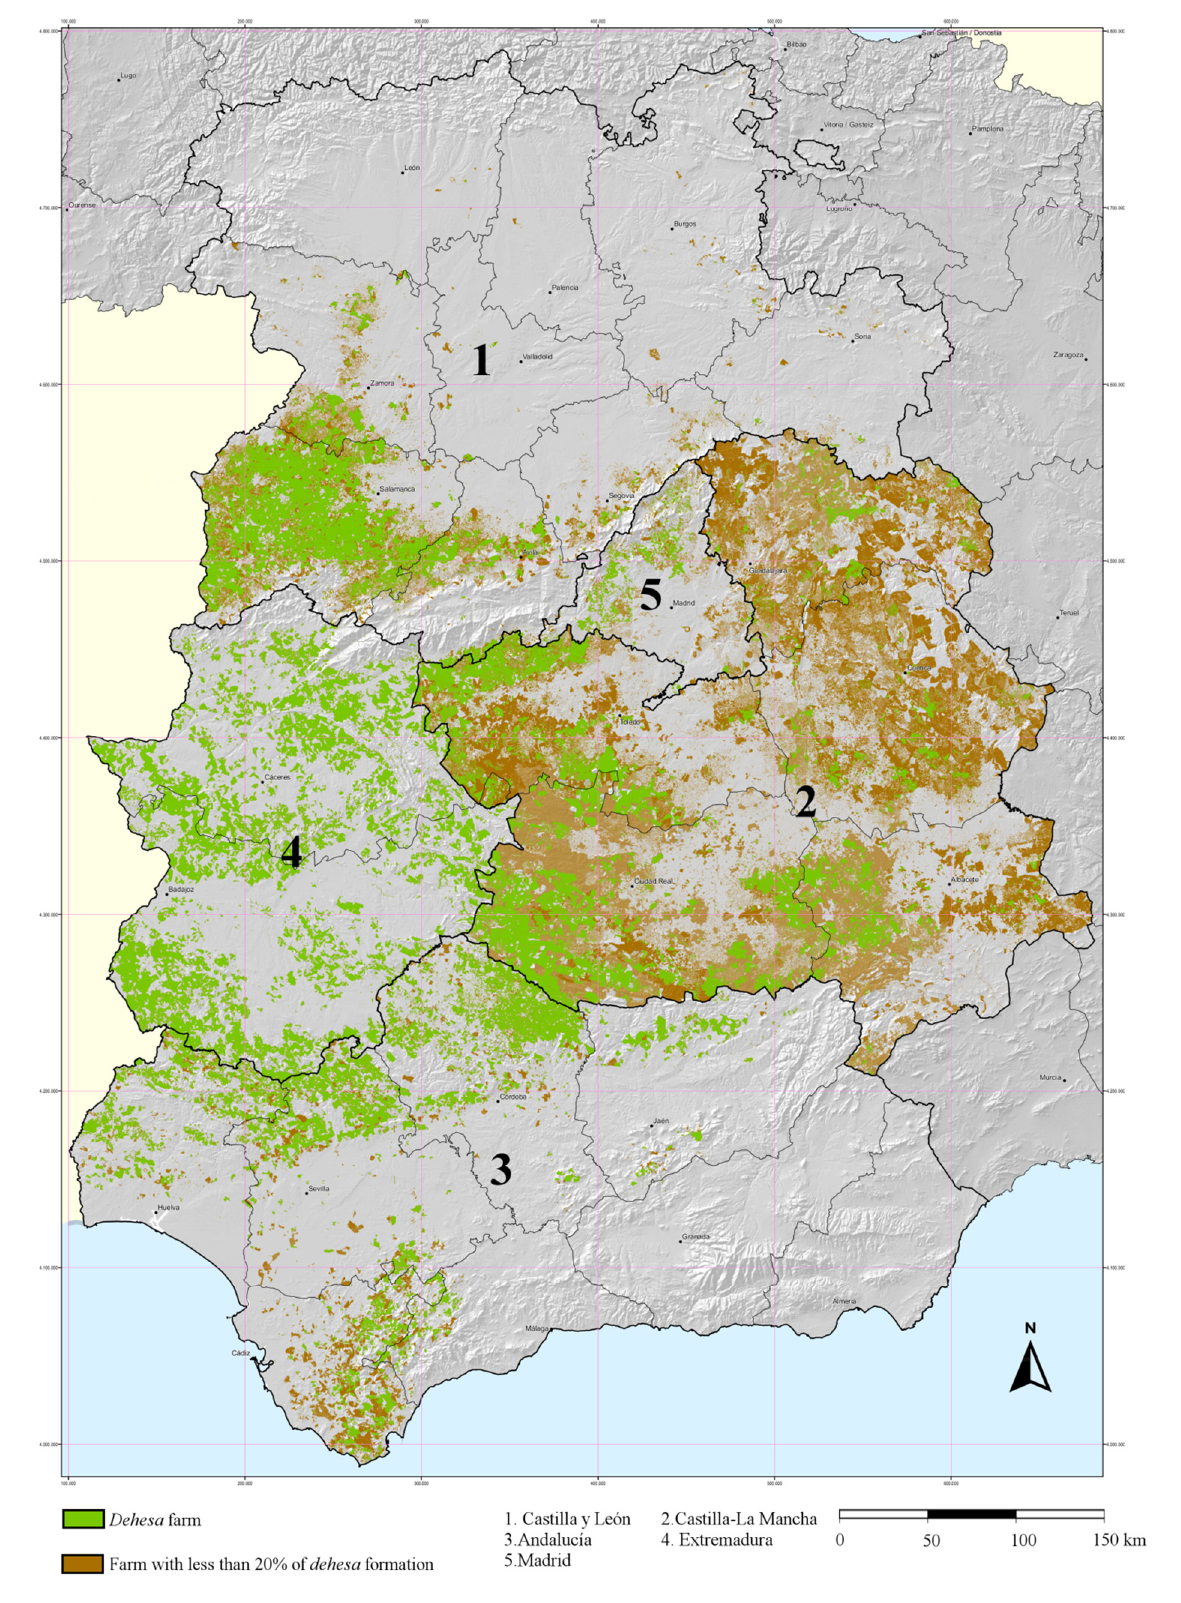
Figure A1. Dehesa farms in five regions in the west, center, and south of Spain. Source: Adapted from [29], Map 3, p. 21.